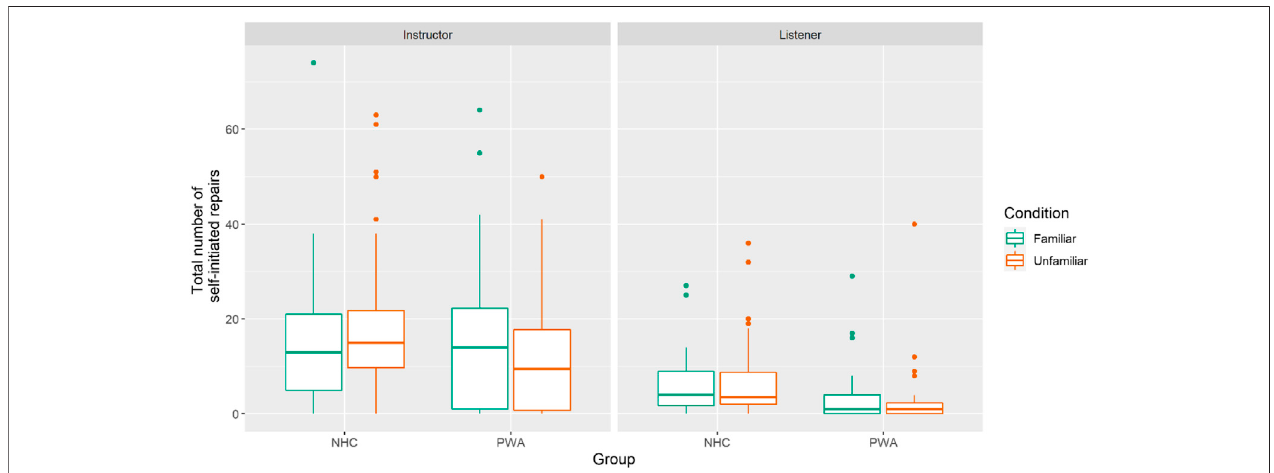
FIGURE 7 | Boxplots showing total number of self-initiated repairs by condition and group, for each role